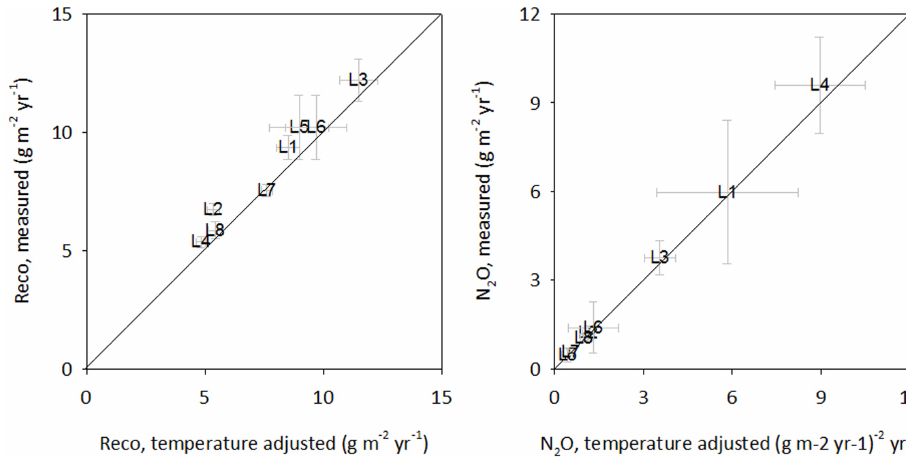
Fig. 11. The scatter plots show the effect of correcting ecosystem respiration ( R eco ) and N 2 O fluxes at the actual measurement time to a temperature corresponding to the daily mean of each sampling day. The correction was made with a modified Van’t Hoff equation and Q 10 values that were site-specific ( R eco ) or fixed (N 2 O) (see text). The data represent mean ± standard error ( n =